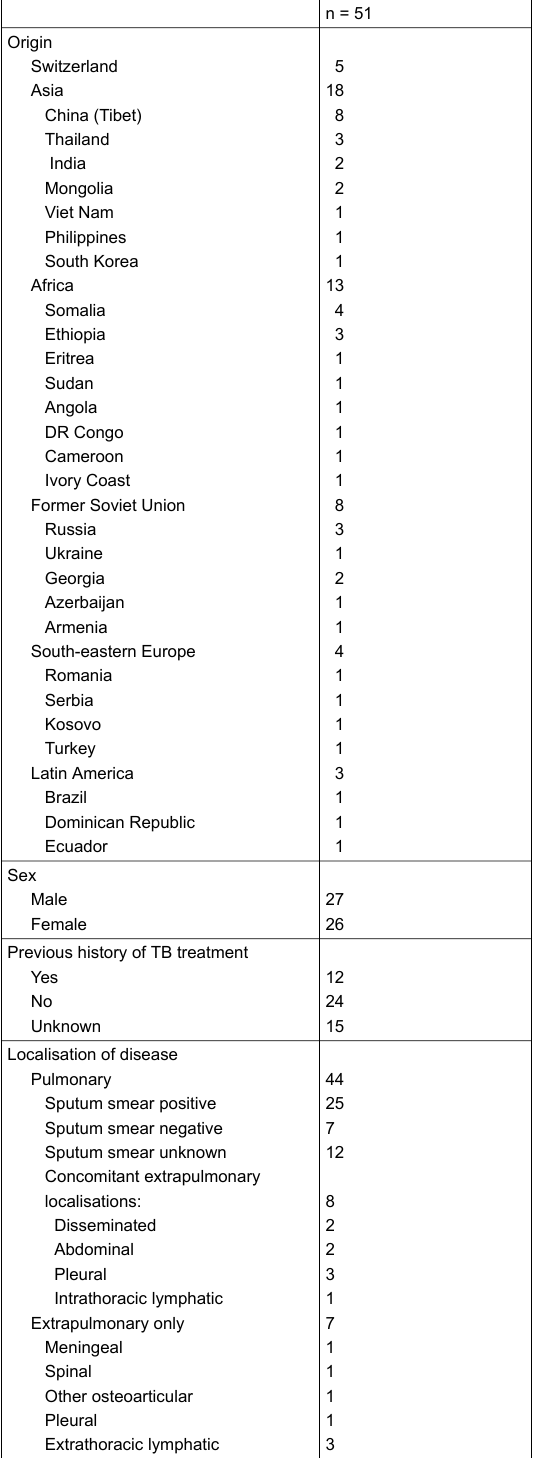
Table 1: Epidemiological baseline data of all 51 MDR-TB cases notified between 01-2003 and 07-2010.